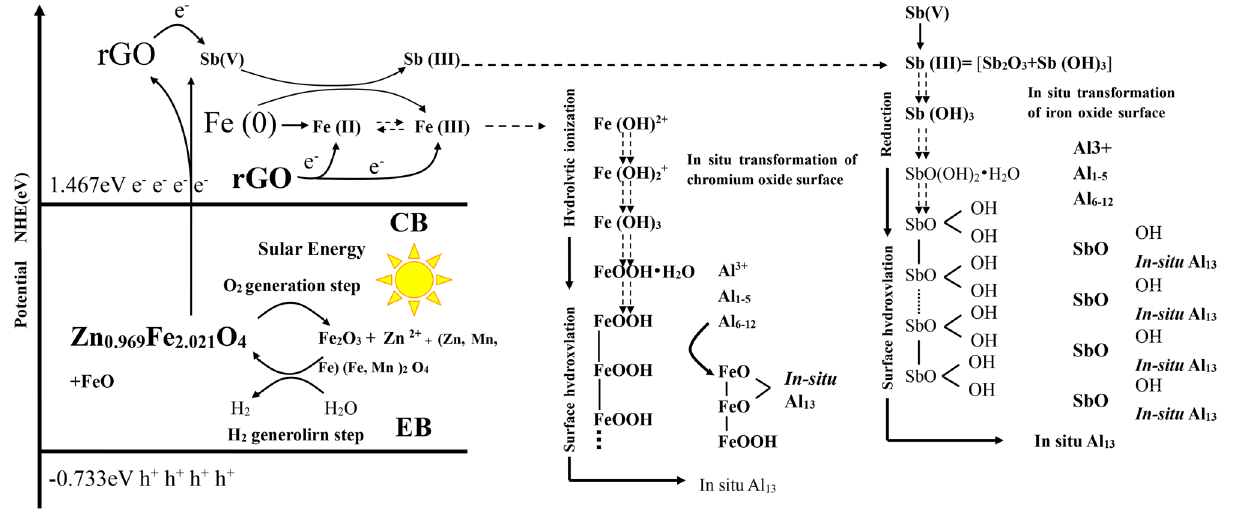
Figure 15. Schematic mechanism of Sb(V) removal by